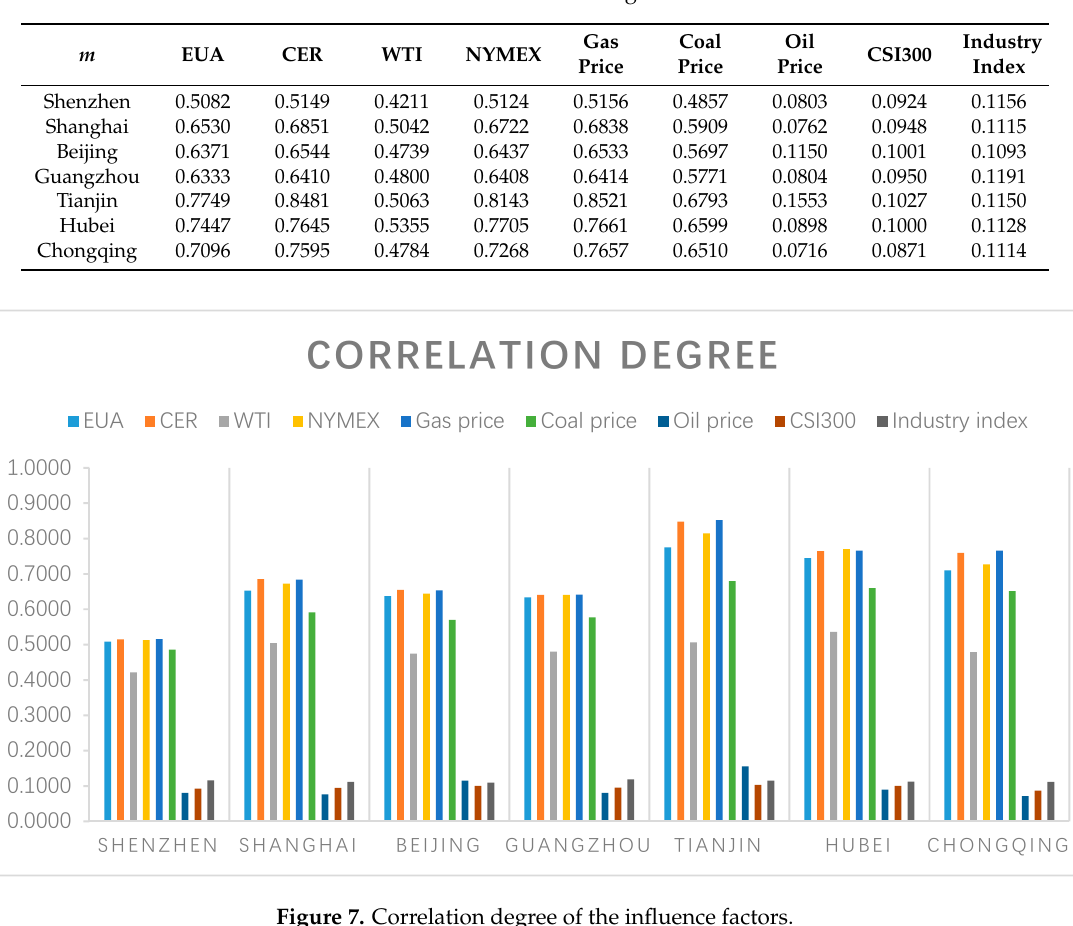
Table 5. Estimated degree of correlation in Deng’s grey relational model.